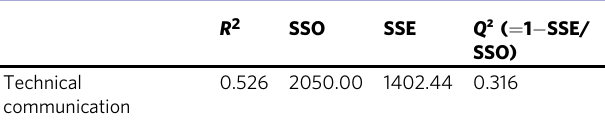
Table 15 Predictive accuracy ( R 2 ) and predictive relevance ( Q 2 ) assessment for the structural